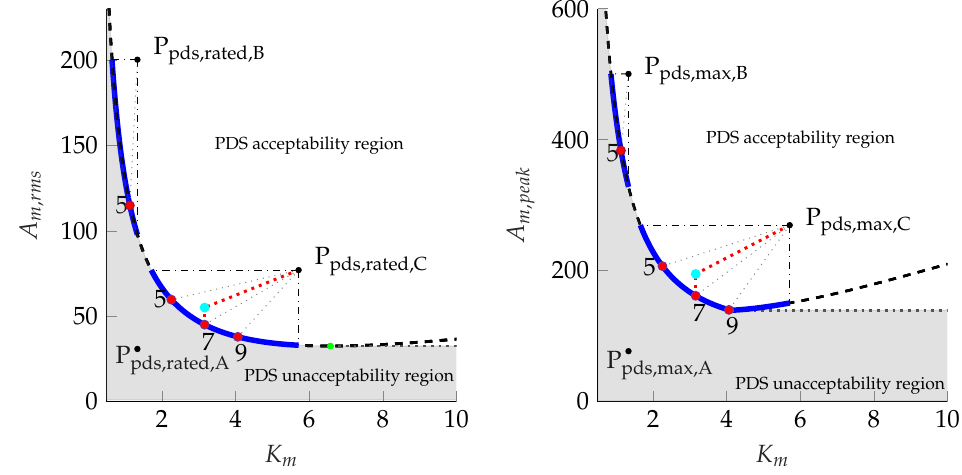
Figure 2. Graphical representation of the main sizing relationships. The black points represent the power drive systems; the red points on the blue feasibility arcs represent ideal P m , rms and P m , peak points at different reduction ratios (whose values are also reported). The points in cyan represent P m , rms and P m , peak obtained from one non-ideal transmission in conjunction with PDS C. The unfeasibility region is filled in